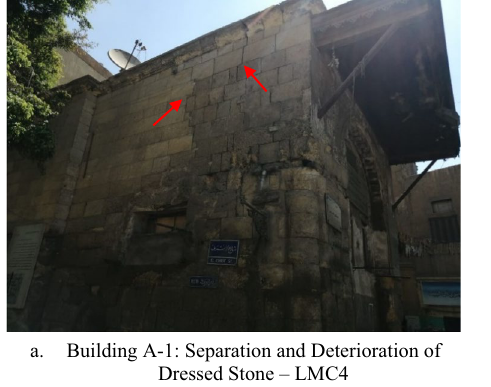
Fig. 8 Observed local mecha- nisms of